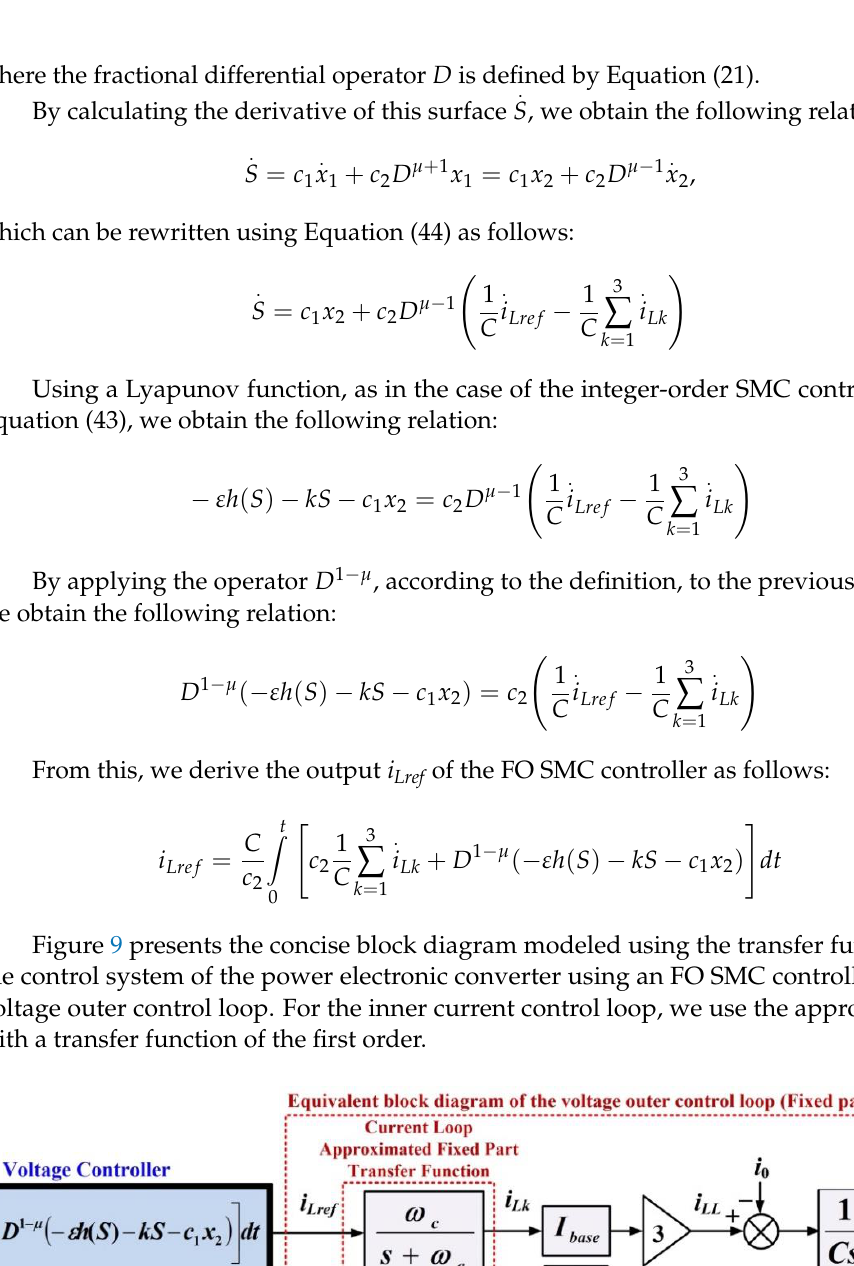
Figure 8. Block diagram modeled using the transfer function for the control system of the power electronic converter using an SMC controller for the voltage outer control loop.